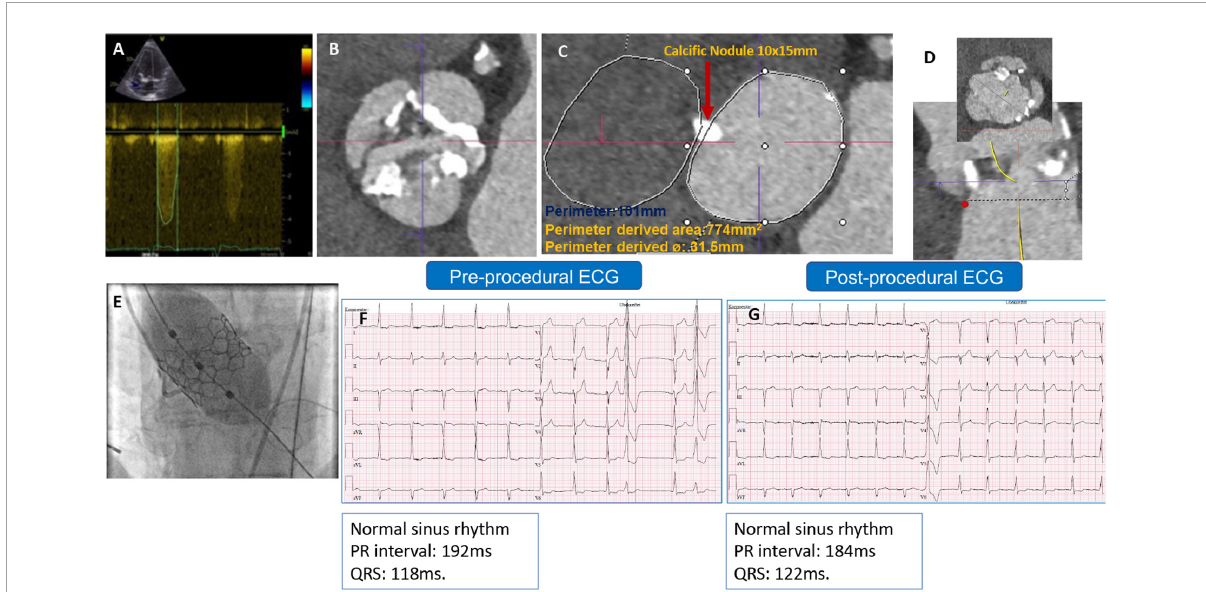
FIGURE2 (A) Preprocedural AV continuous wave Doppler with high maximum velocity, (B) preprocedural MSCT showing BAV with partially fused L-R raphe and significant AV calcifications, (C) annulus measurement showing large annulus with large annular calcific nodule, (D) LVOT profile view (no calcification) and ICD 4–5 mm above the annulus = 35 mm, (E) Myval-XL 32 mm deployment, (F) preprocedural ECG, and (G) postprocedural ECG without changes.